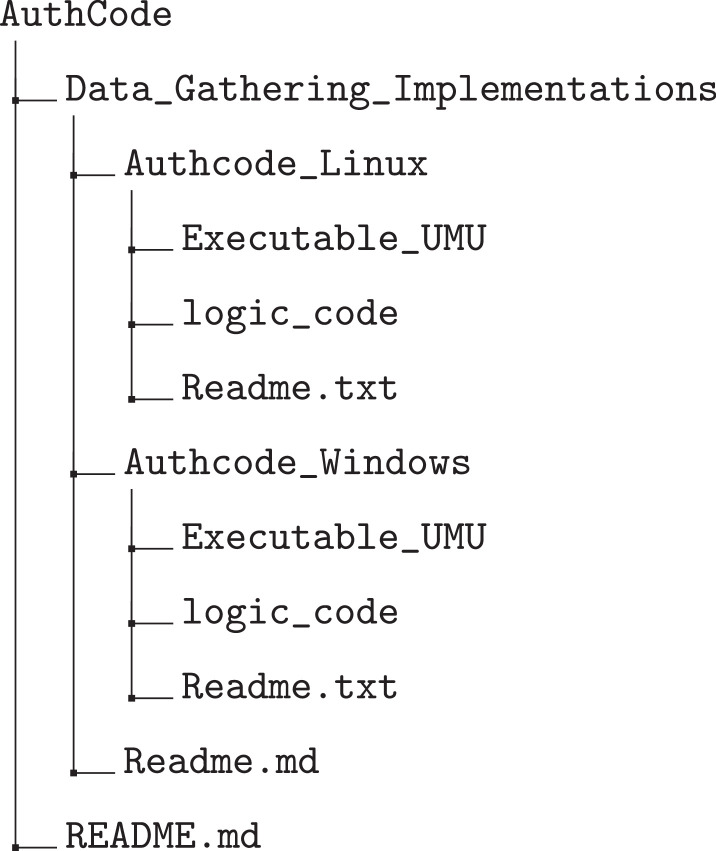
Code repository [2] structure.